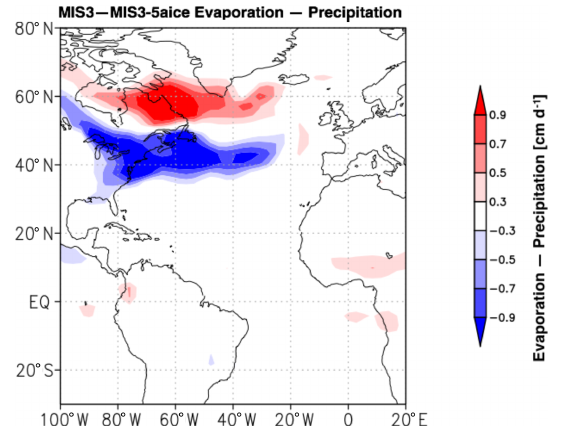
Figure 9. Anomalies of atmospheric freshwater flux ( E − P , cmd − 1 ) out of the ocean between MIS3 and MIS3-5aice. Red rep- resents freshwater flux out of the ocean, and blue represents fresh- water flux into the ocean. The climatology of the last 100 years is used to create these figures.